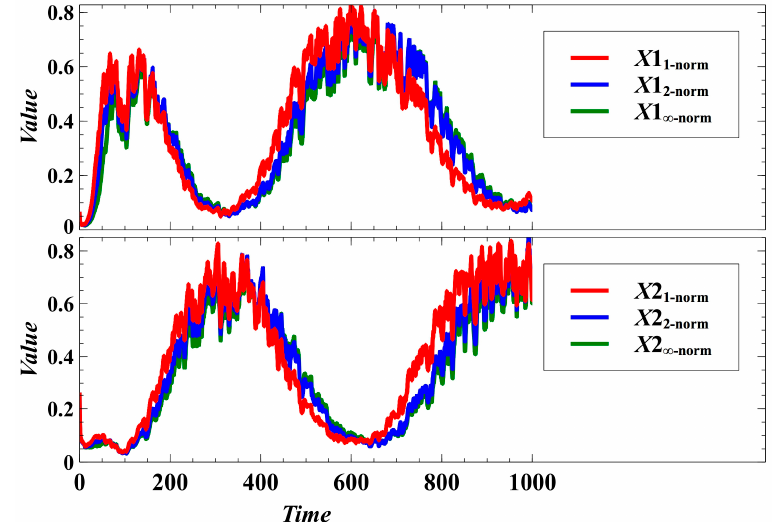
Figure A1. Effect of using different norms in the population dynamics of the host species under the stochastic case, with r 1 and r 2 as the evolving traits.